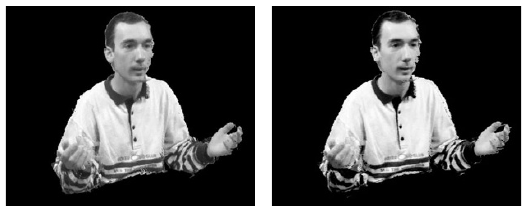
Figure 17: The reconstructed novel view from our multi-step algo- rithm (left) compared with that from the trifocal tensor approach (right) using the same input data and system configuration as in Figure 11. Except that the reconstructed view from our algorithm is a bit sharper, they are comparable with each